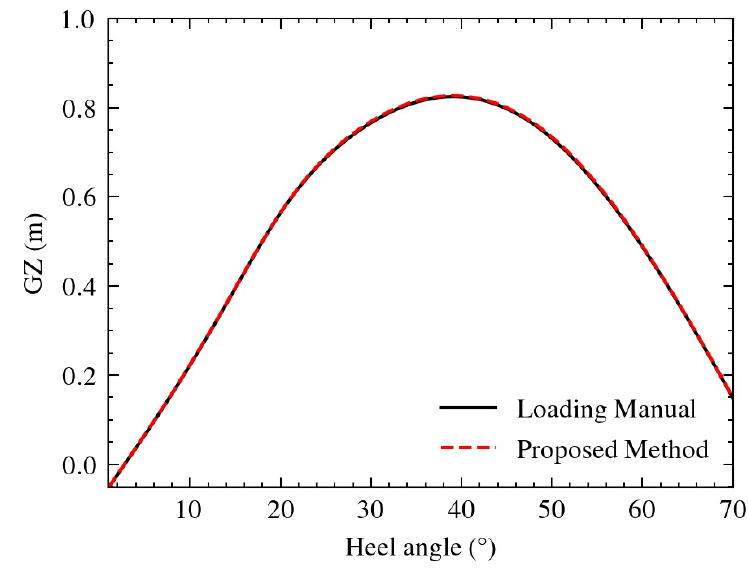
Figure 12. GZ curve of